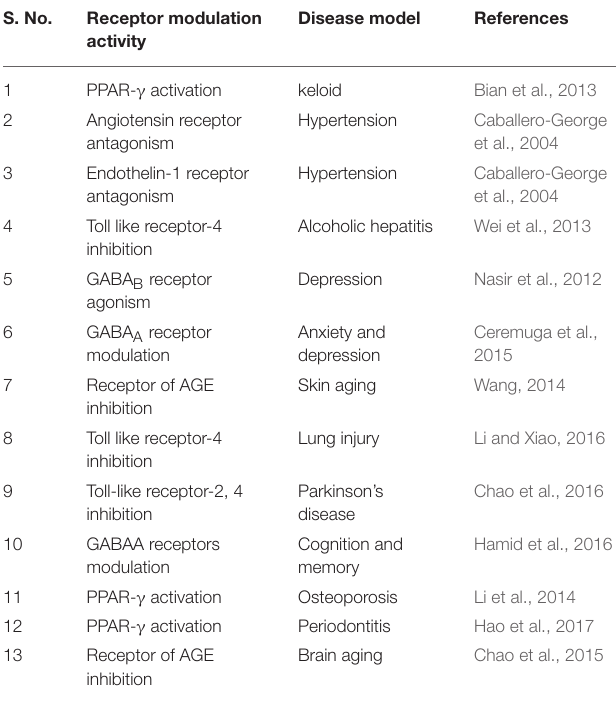
TABLE 5 | The receptor modulator properties of asiatic